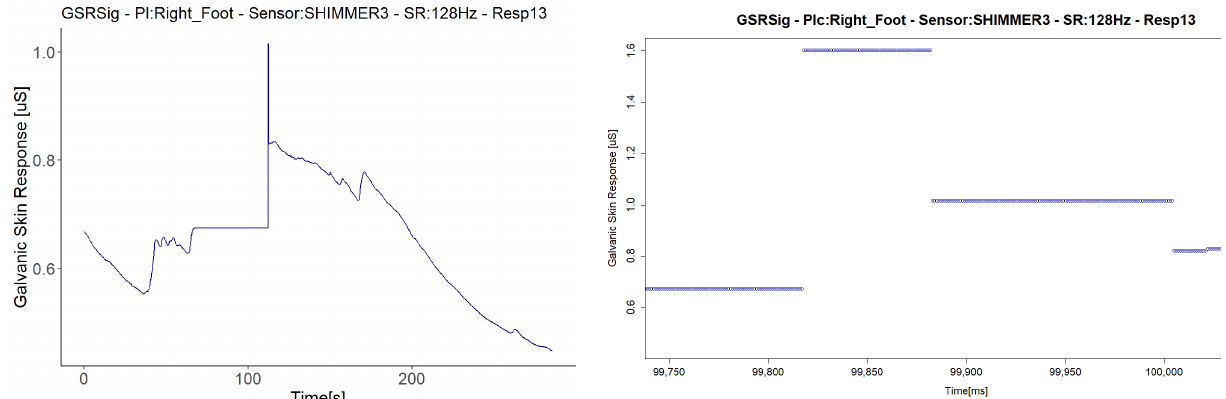
Figure 13. Illustration of the detected constant value anomaly. On the left are the signals with the anomaly turned into a graph from the downsampled data; on the right are other signals measured in the same respondent with the same type of sensor, turned into a graph from the raw data, zoomed in on the time interval.